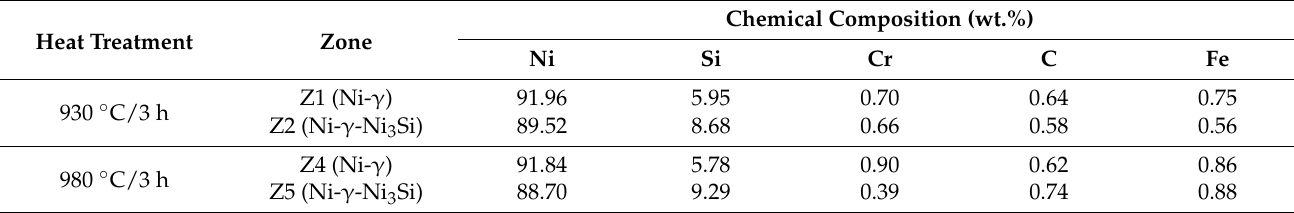
Figure 4. Effect of the solution heat treatment on the microstructure of NiSi3B2 alloy: ( a ) the as-cast condition; ( b ) 930 ◦ C/0.5 h; ( c ) 980 ◦ C/0.5 h; ( d ) 930 ◦ C/3 h; and ( e ) 980 ◦ C/3 h. Table 3. SEM-EDS results of the NiSi3B2 alloy solutionized at 930 ◦ C and 980 ◦ C for 3